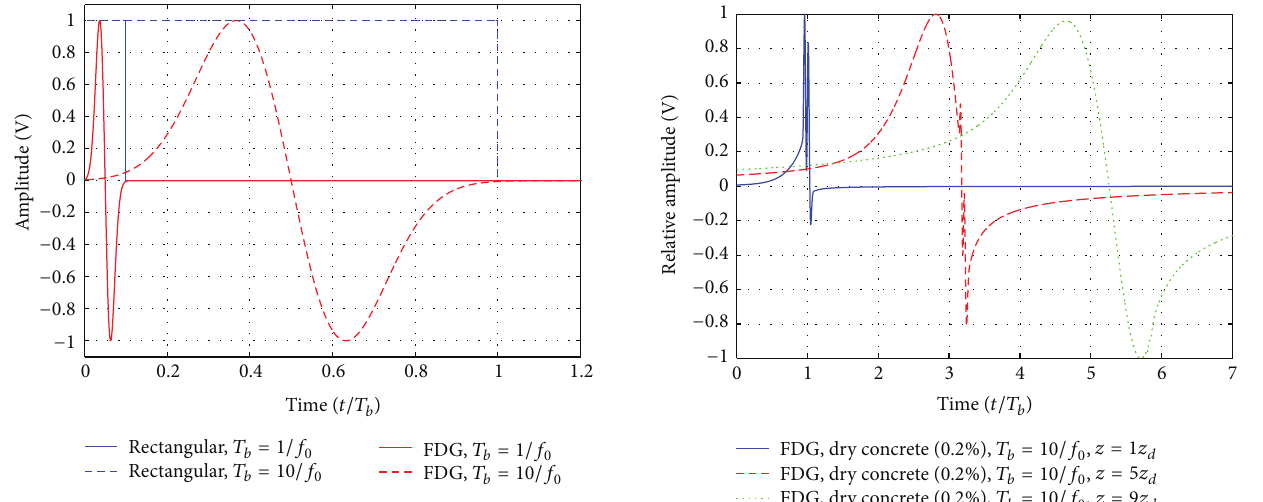
Figure 5: Normalized electric field evolution through different propagation distances within a dielectric slab of dry concrete (0.2% moisture content) for a FDG pulse with 𝑓 = 1.5 GHz and 𝑇 𝑏 = 10/𝑓 0 .